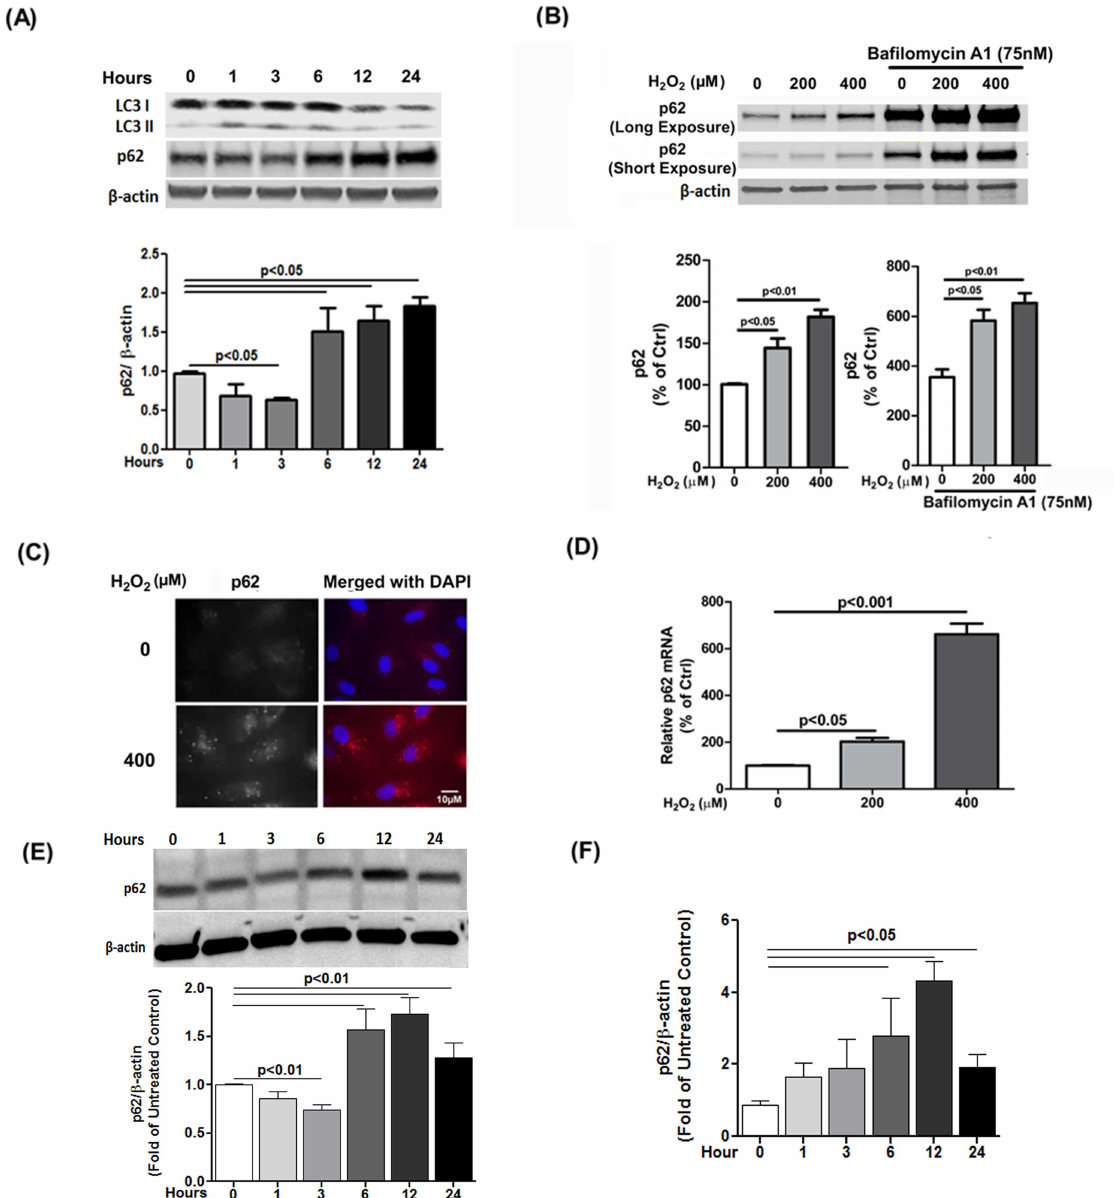
Fig 1. H 2 O 2 exposure increasesautophagic flux and p62 expression in RPE cells. (A) ARPE-19 cells were exposedto 400 μ MH 2 O 2 and autophagywas monitored on western blots of protein lysates followingtreatment at 1, 3, 6, 12 and 24h by LC3 II/ I conversionand p62/SQSTM1 levels using anti-LC3 and anti-p62/SQSTM1 antibodiesrespectively. β -actinwas used as an internalcontrol (upper panel). p62 levels were analyzedby densitometry as describedin Experimental Procedures(lower panel). (B) ARPE-19 cells were exposedto 200 or 400 μ MH 2 O 2 for 24h and p62 protein levels were monitored by Western blot and analyzedby densitometry. β -actin was used as an internalcontrol. Control(Ctrl) is H 2 O 2 (0 μ M)without BafilomycinA1. ‘Short’ and ‘Long’Exposure indicatetime of exposure of immunoblot image. (C) Confocalimages of control ARPE-19 cell cultures and ARPE-19 cells following6h exposureto 400 μ MH 2 O 2 labelledwith anti-p62(red) and nuclear-stained with DAPI (blue). (D) ARPE- 19 cells were treated with 200 or 400 μ MH 2 O 2 for 24h and mRNA extracted. p62 mRNA level was determined by qRT-PCR with p62 specific primers. (E) Primary human fetal RPE cells were exposedto H 2 O 2 (400 μ M)and and p62/SQSTM1 levels were monitoredby Western blot of protein lysates followingtreatment at 1, 3, 6, 12 and 24h using anti-p62antibody. β -actin was used as an internalcontrol (upper panel). Densitometric analyseswere plotted in the lower panel. (F) Primary humanfetal RPE cells were treated with H 2 O 2 for 24h and then p62 mRNA level was examinedby relative quantitative real-time qRT-PCR with p62 specific primers. Statistical significancebetweenuntreatedcontrol and H 2 O 2 -exposed cells was determinedby Mann-Whitney U- test, p <